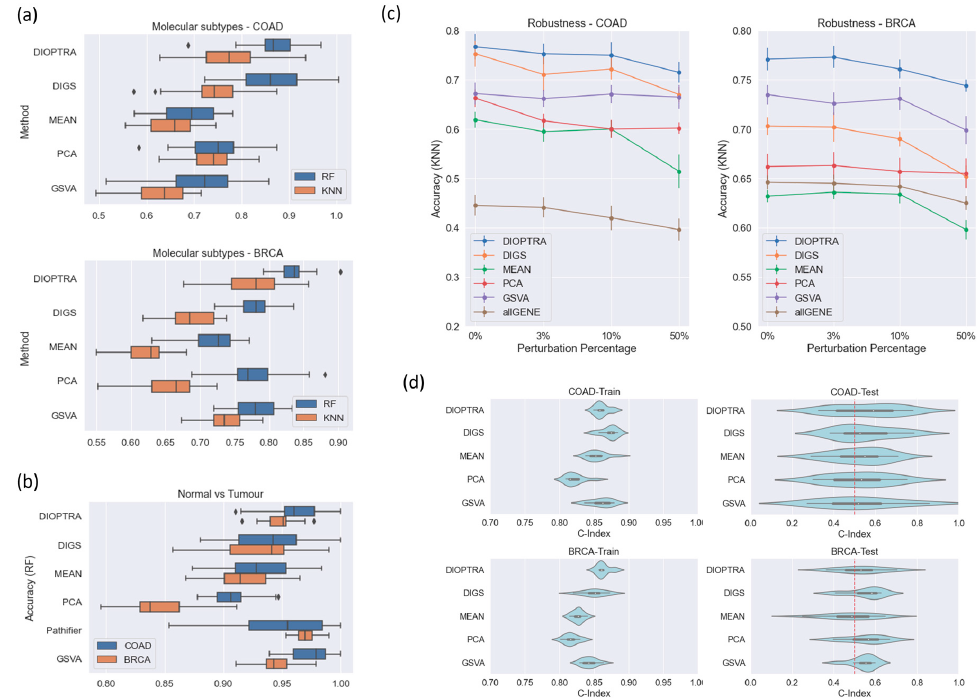
Figure 3. Assessment of pathway activity inference methods. ( a ) Comparison of pathway activity inference prediction performance by Random Forest (RF) and K-Nearest Neighbour (KNN) on the multi-class scenario. ( b ) Prediction performance comparison on the two-class scenario, including the Pathifier method, which is designed for binary labelled data. ( c ) Prediction accuracy (multi-class scenario) with noise introduced to the RNA-Seq data. The x-axis represents the percentage of samples perturbed and the y-axis indicates the prediction accuracy and standard errors of KNN over one instance of ten-fold cross-validation. AllGENE refers to directly using the gene expression values to train and test the classifier. ( d ) C-index for evaluating the Random Survival Forest model fitted on the pathway activity (multi-class scenario); C-index = 0.5 indicates the performance of a random